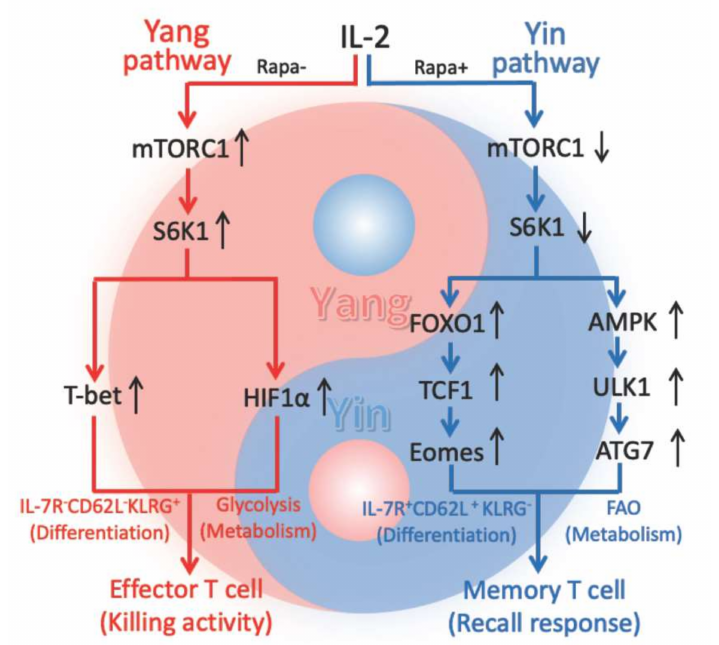
Figure 6. Schematic diagram showing that IL-2(Rapa+)/T with weak mTORC1/S6K (weak yang) but strong AMPK (yin) signaling become T-cell memory via activation of the (yin) FOXO1-TCF1-Eomes transcriptional pathway and the (yin) AMPK-ULK1-ATG7 metabolic axis, whereas IL-2/T-cells with strong mTOC1/S6K1 (yang) signaling differentiate into effector T-cells via activation of the (yang) T-bet transcriptional and the (yang) HIF-1 α metabolic pathways. In the figure, red color part represents yang controlling cell growth, differentiation and functional effect, and using glycolysis for cell metabolic energy while blue color part represents yin regulating cell quiescence, and using FAO for cell metabolic